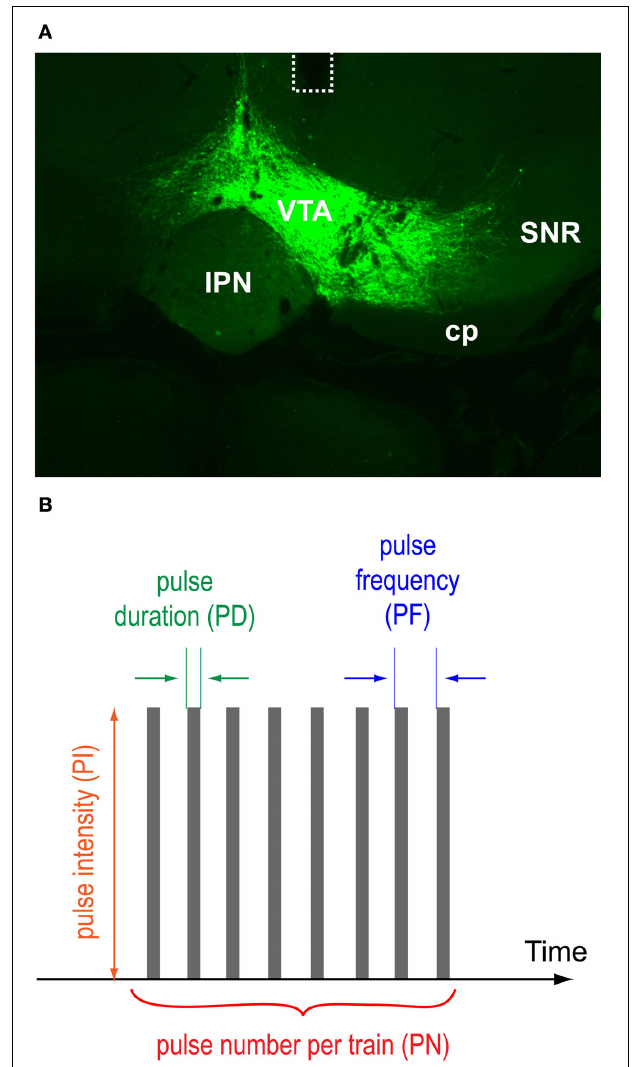
FIGURE 1 | VTA protein expression, optic fiber placements, and pulse-train parameters. (A) A photomicrogram showing representative EYFP expression with the placement of an optic fiber (dotted line). Abbreviations: cp, cerebral peduncle; IPN, interpeduncular nucleus; SNR, substantia nigra pars reticulata; VTA, ventral tegmental area. (B) Pulse duration, intensity, frequency, and number of a photo-pulse trains